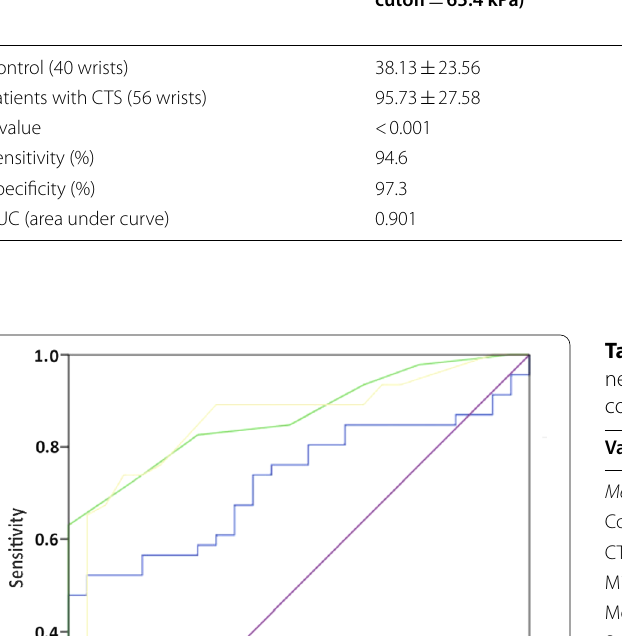
Table 1 Quantitative analysis of CSA of median nerve, wrist/forearm ratio and mean stiffness (elasticity) by ROC analysis between CTS patients and controls